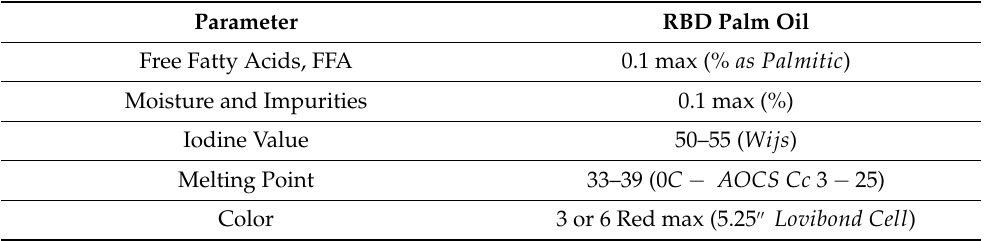
Table 3. PORAM (Palm Oil Refiners Association of Malaysia) standard specifications for refined palm oils.